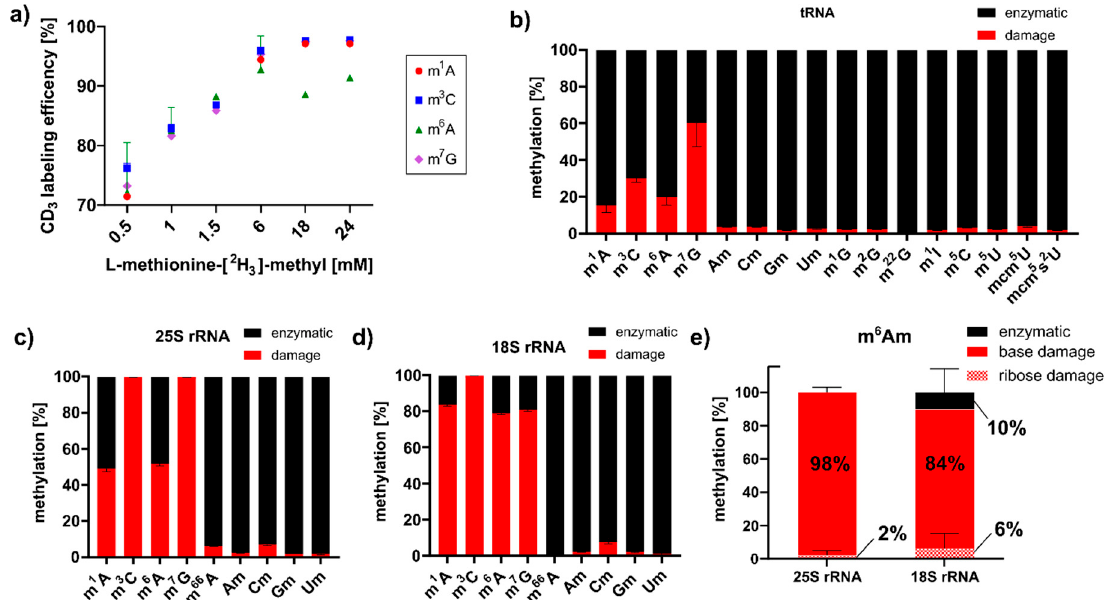
Figure 2. Methylome discrimination assay in S. cerevisiae . ( a ) Titration of optimal L-methionine-[ 2 H 3 ]-methyl supplementa- tion to receive the highest abundance of CD 3 -labeled RNA modifications. ( b – d ) Ratios of damaged (red) to enzymatically (black) methylated nucleosides in S. cerevisiae tRNA ( b ), 25S rRNA ( c ) and 18S rRNA ( d ) after 60 min of MMS exposure. ( e ) The methylome discrimination assay reveals the origin of the methylation in the newly identified RNA damage product m 6 Am.